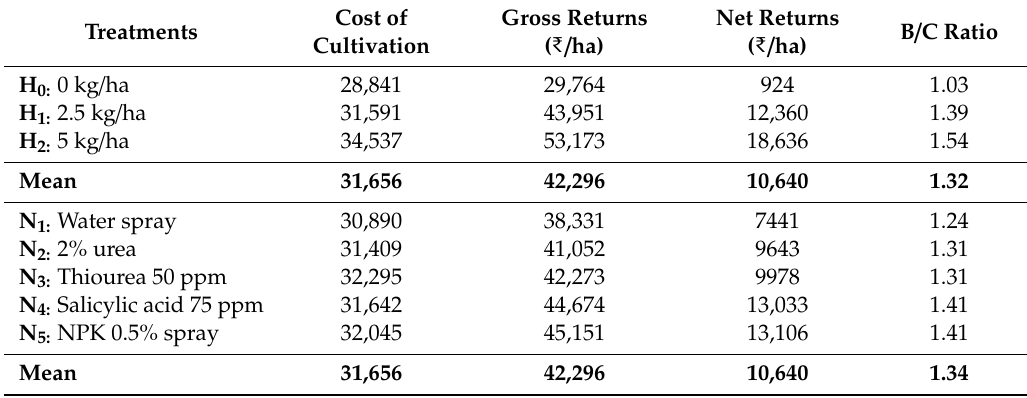
Table 5. Economics of lentil as influenced by the application of hydrogel and foliar nutrition (average data of three